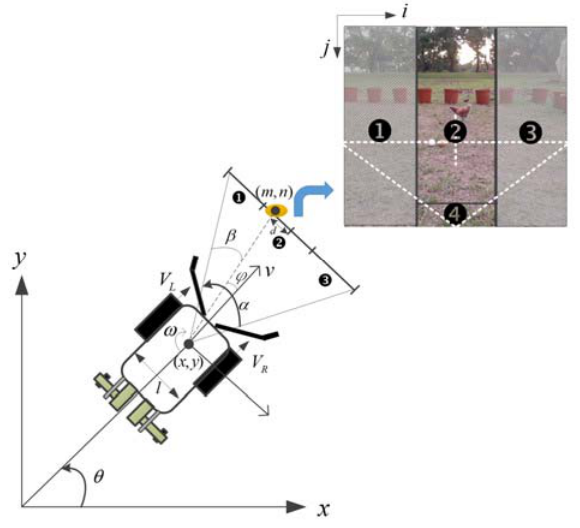
Figure 1. Coordinate system used for the mobile robot.